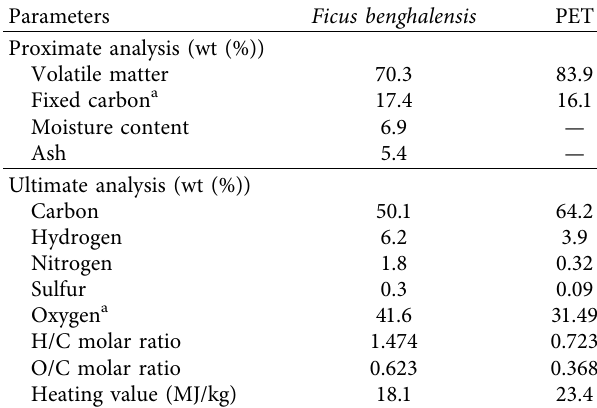
Table 1: Characterization of the